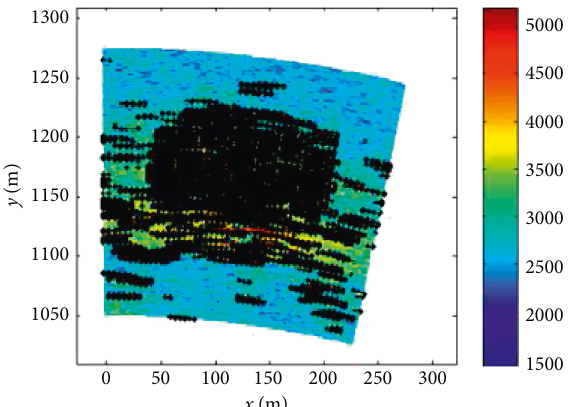
Figure 5: PS points extracted using the correlation coefficient threshold method (the black dots are